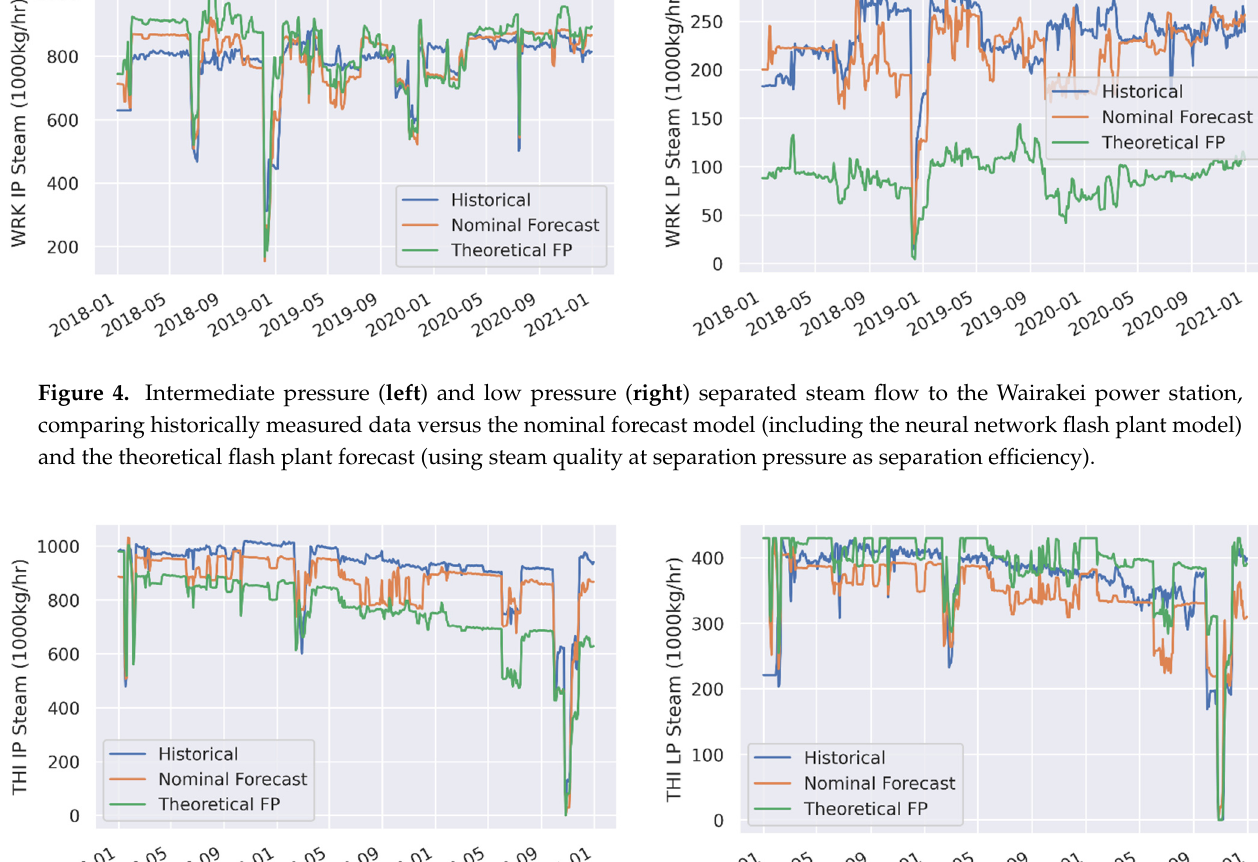
Figure 3. Total system separated steam flow, comparing historically measured data versus the nominal forecast model (including the neural network flash plant model) and the theoretical flash plant forecast (using steam quality at separation pressure as separation efficiency).